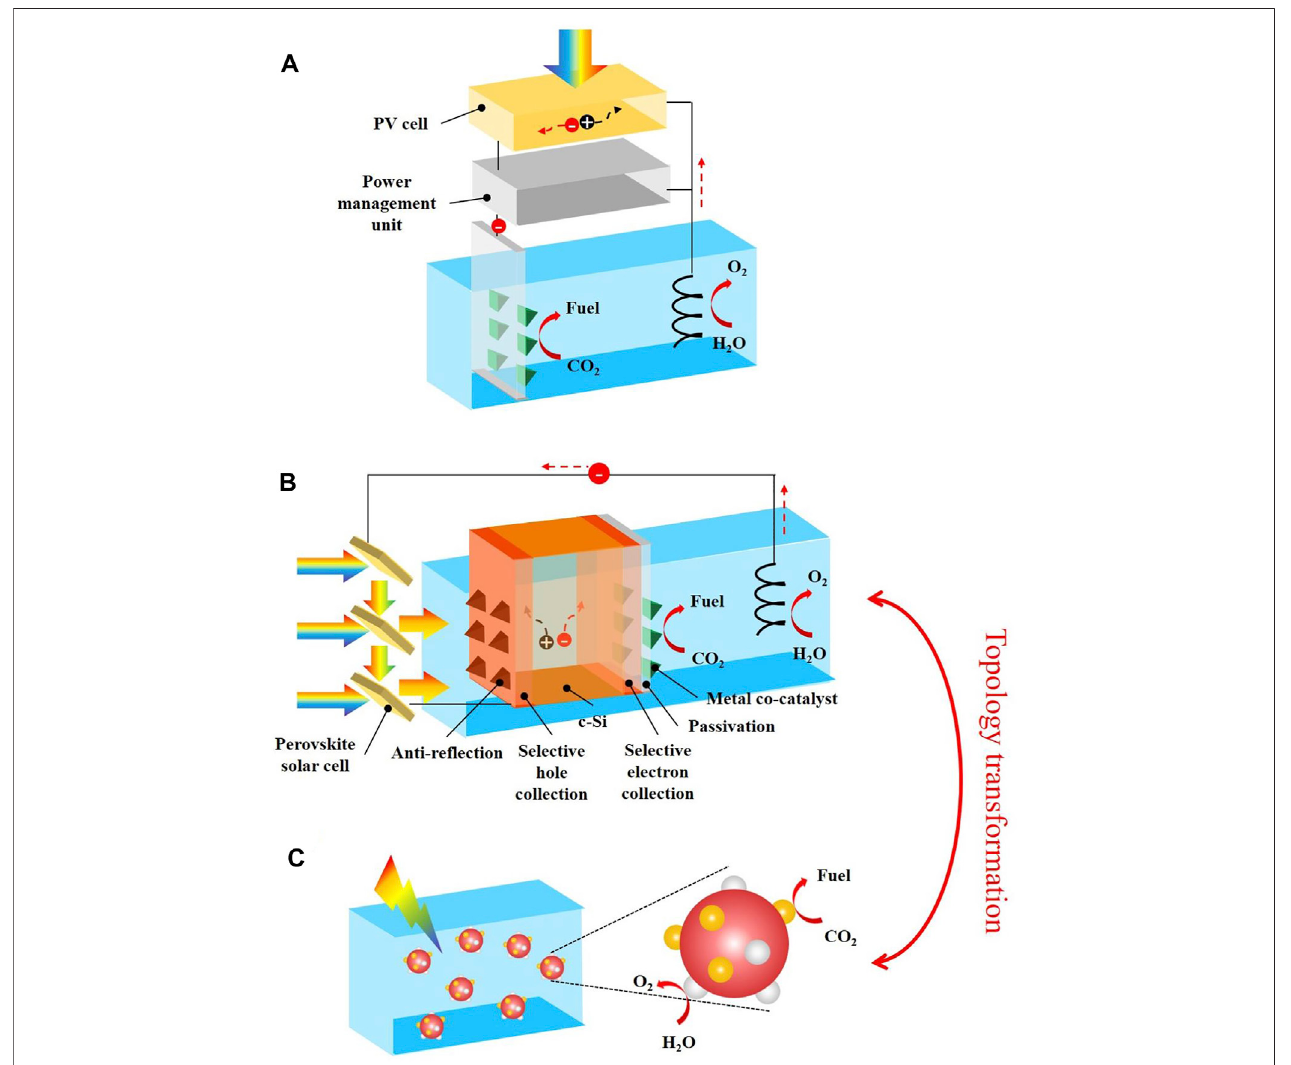
FIGURE 1 | Solar-driven CO2RR approaches investigated in this work. (A) PV-EC CO2RR with a power management unit. (B) PV-PEC CO2RR with the device architecture designed in this work. (C) CO2RR using suspended semiconductor nanoparticles with two different co-catalysts deposited on the surface, which is topologically transformed from PEC